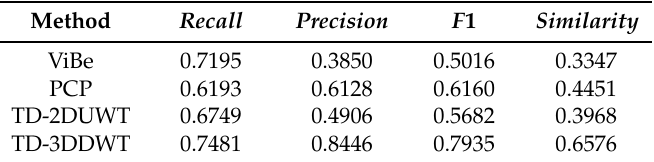
Table 13. Comparison of average metrics for the tram crossroad sequence.